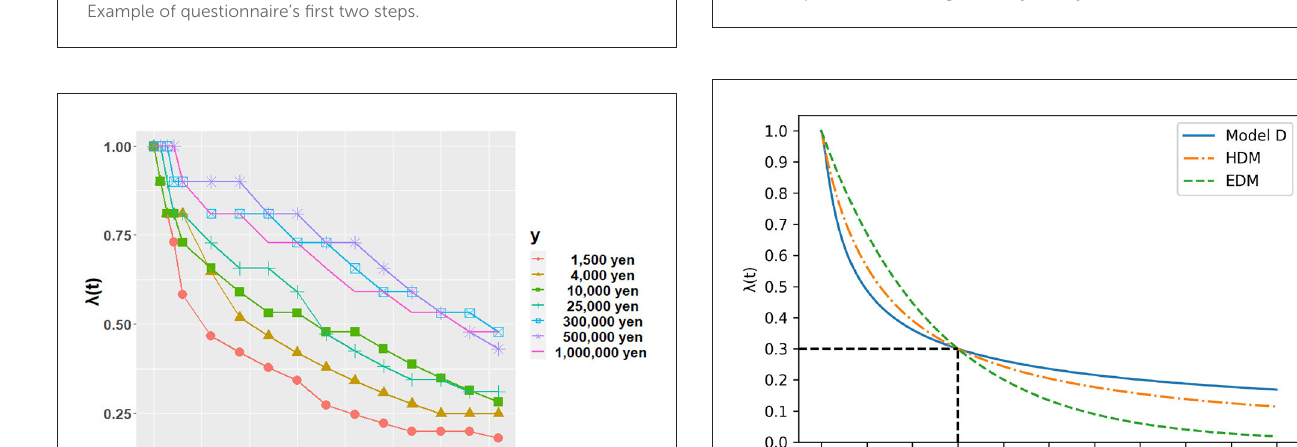
FIGURE5 The shape of functions regressed by AI-Feynman.